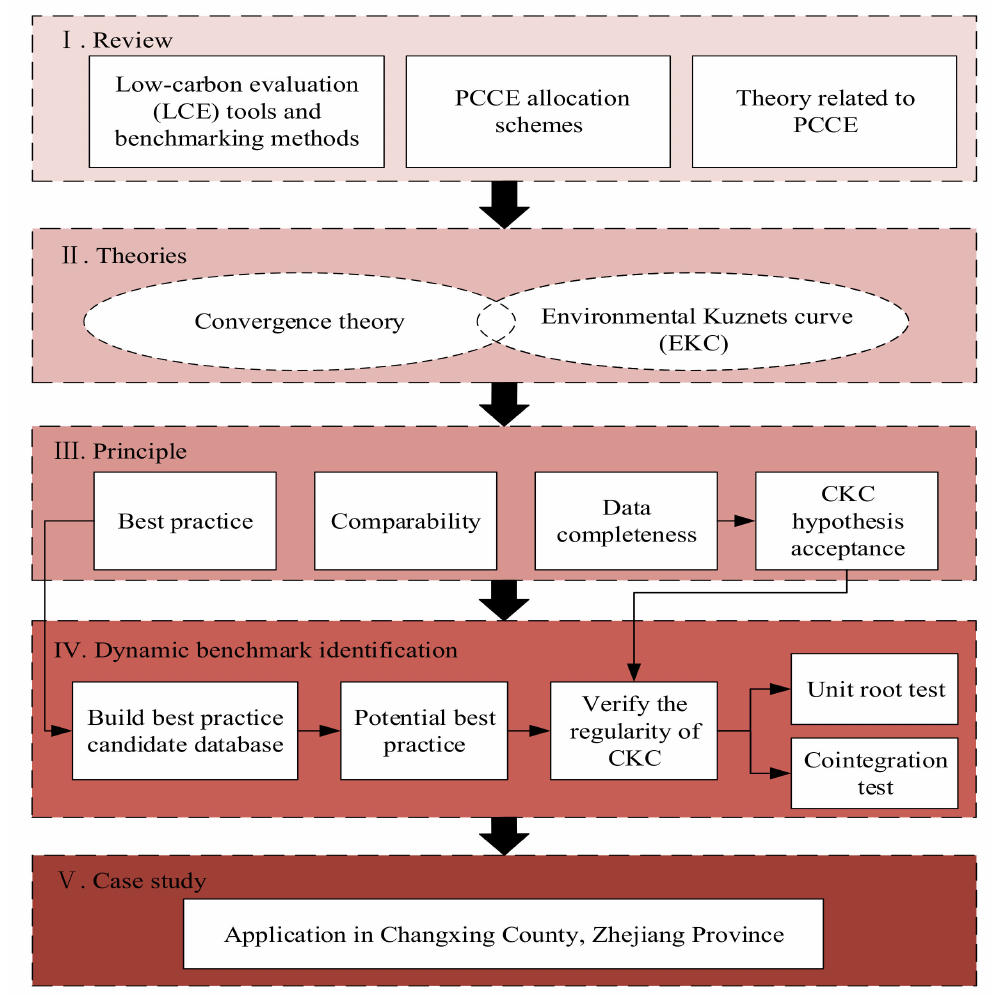
Figure 2. Research framework of the dynamic benchmark system for county